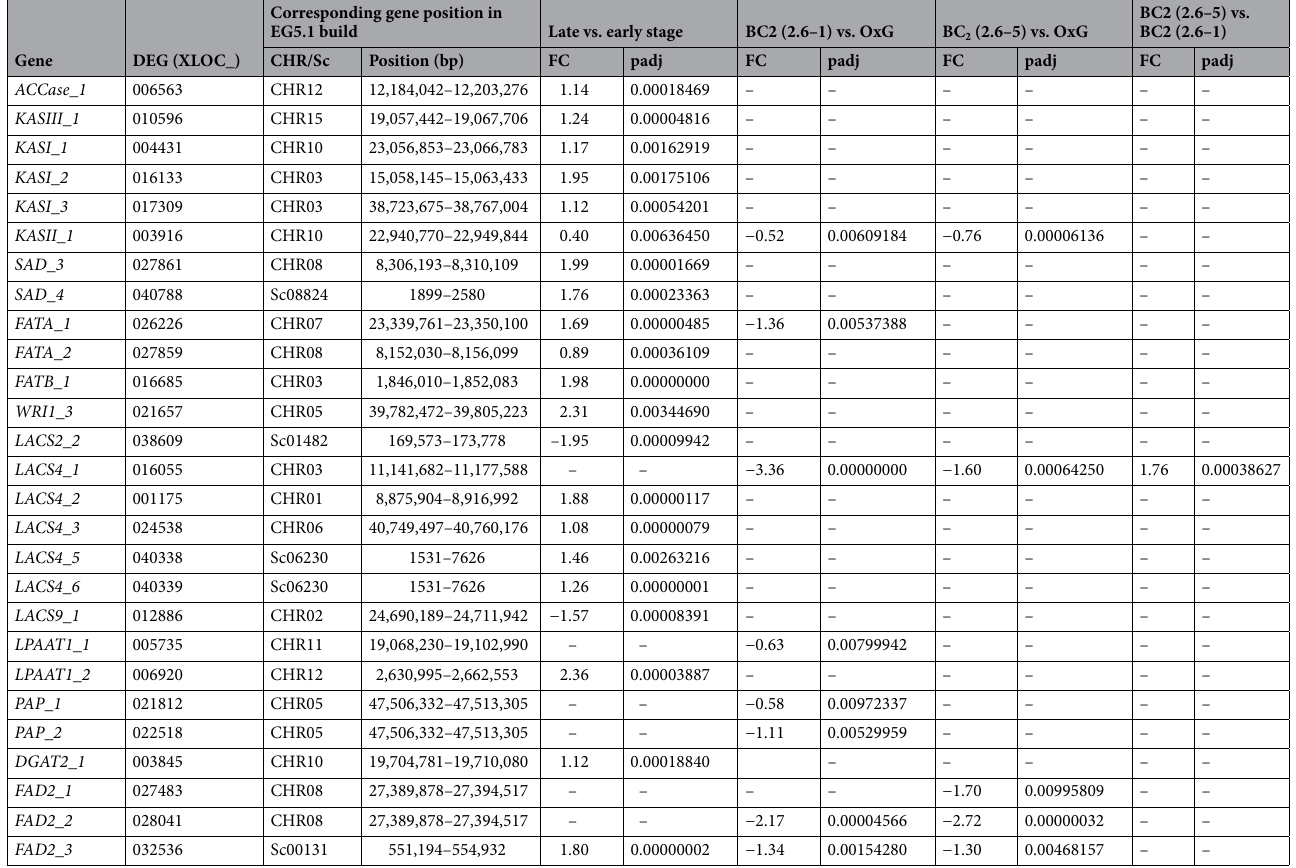
Table 3. Differentially expressed genes (DEGs) related to synthesis of FA (GO:0006633, GO:0006636 and GO:0008610) and TAG (GO:0019432) identified by comparing the two mesocarp developmental stages (late and early) and amongst the OxG, BC 2 (2.6–1) and (2.6–5) populations. Significant in expression at adjusted p value (padj) < 0.01 determined with H 0 : log 2 fold change (FC) =